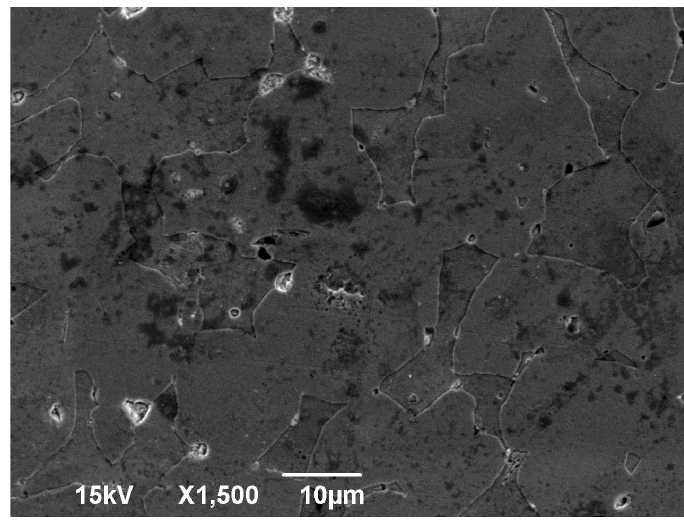
Figure 2. SEM image of brass alloy; magnification ×1500.